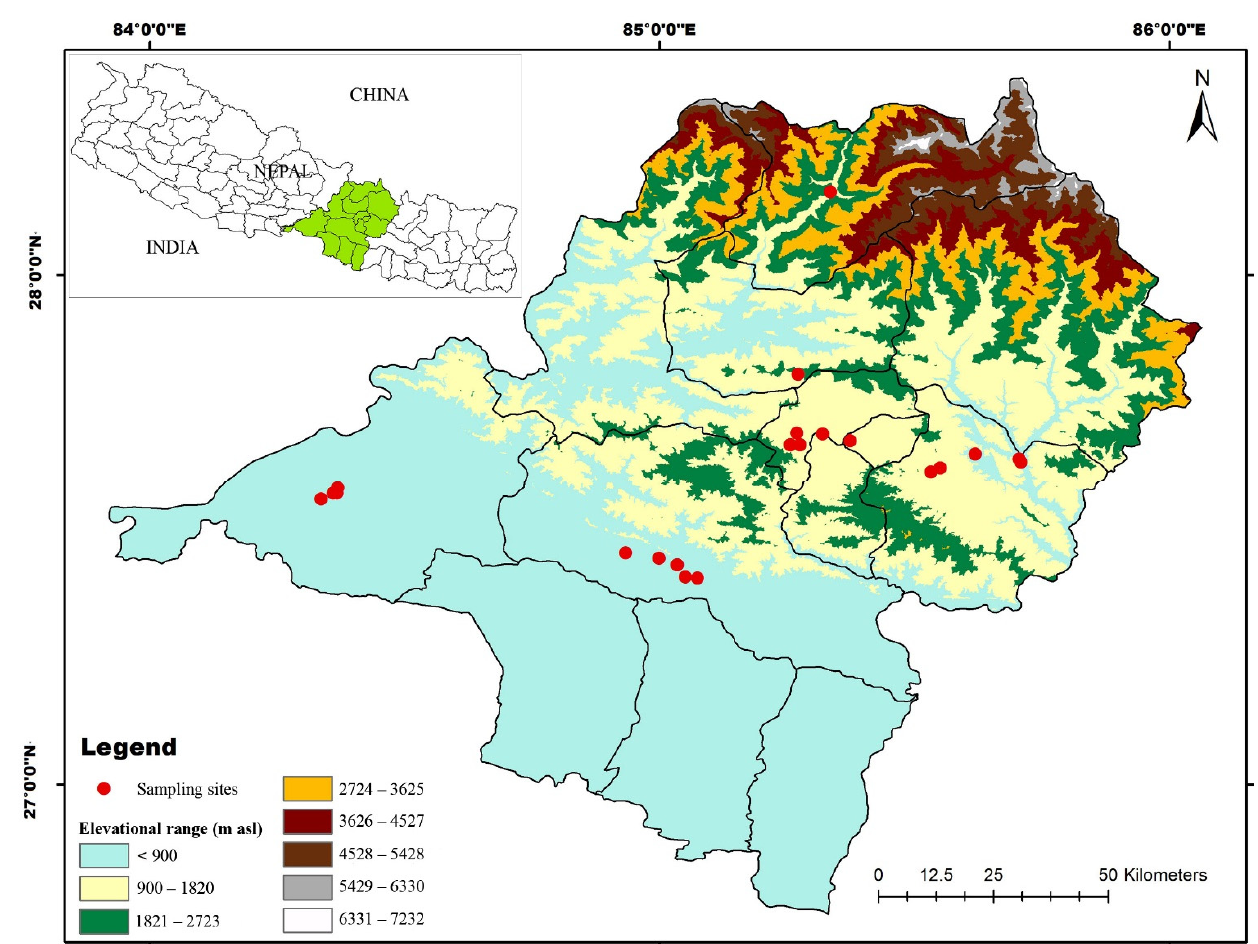
Figure 1. Map of central Nepal showing sampling areas (red dots) of Passer spp. from different ele- vations.